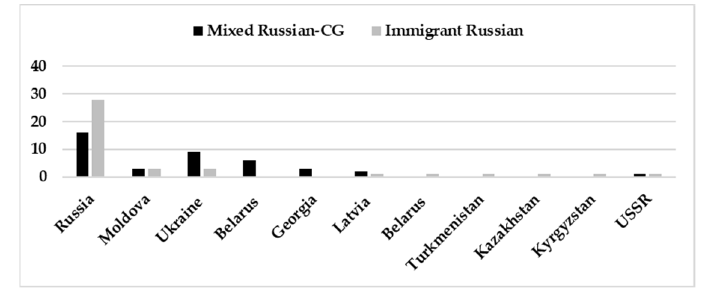
Figure 1. Participants: Country of origin.